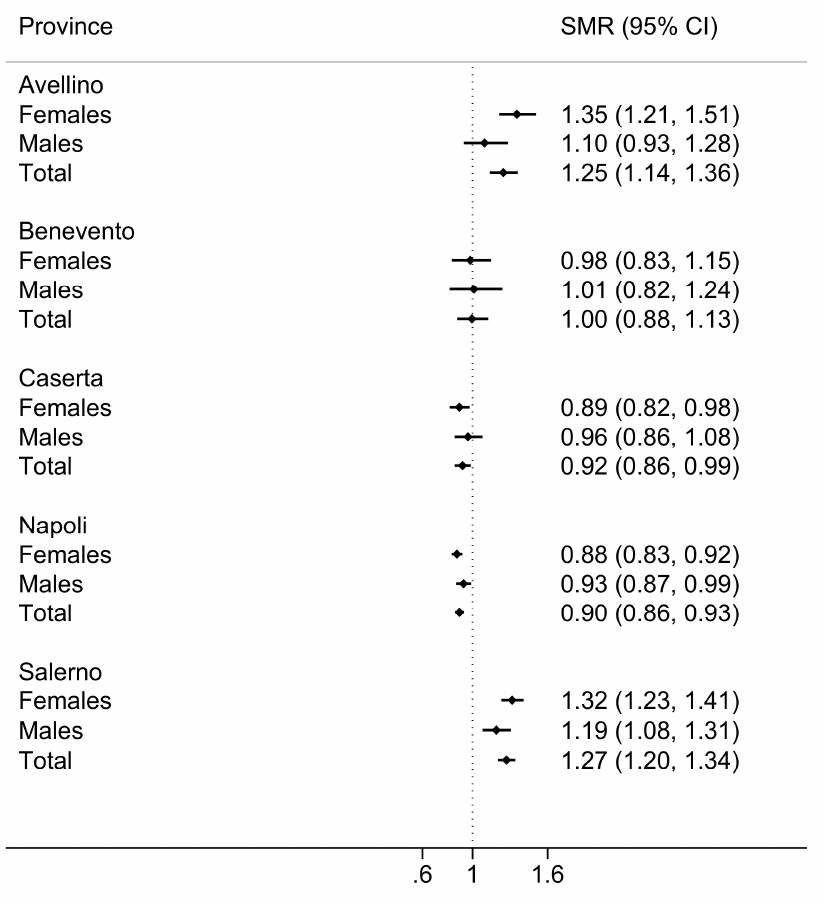
Figure 3. Prevalence of MS in the Provinces of the Campania Region.